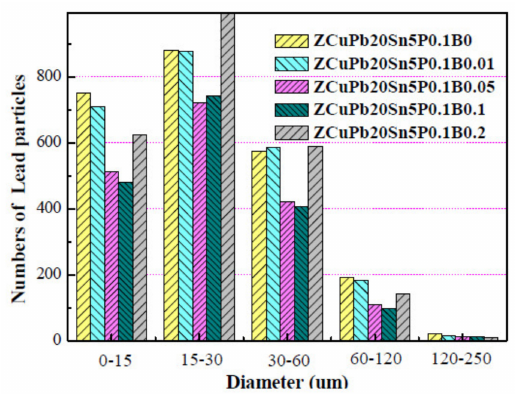
Figure 3. Lead particle number distribution map of ZCuPb20Sn5-yB